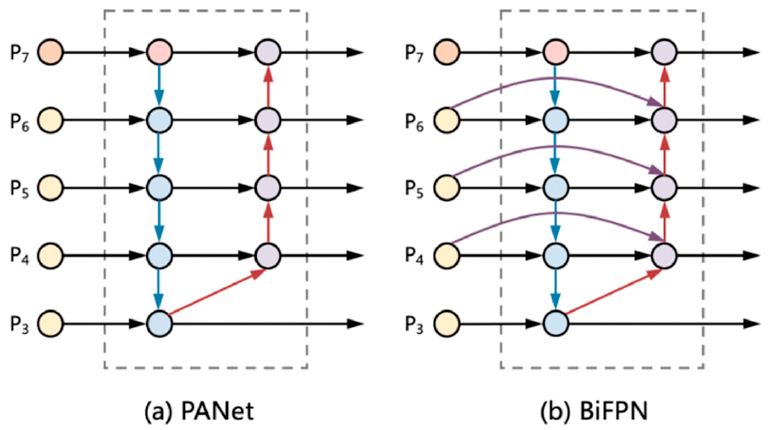
Figure 4. Feature network design ( a ) PANet adds an additional bottom-up pathway on top of FPN. ( b ) BiFPN implements two optimizations for cross-scale connections.